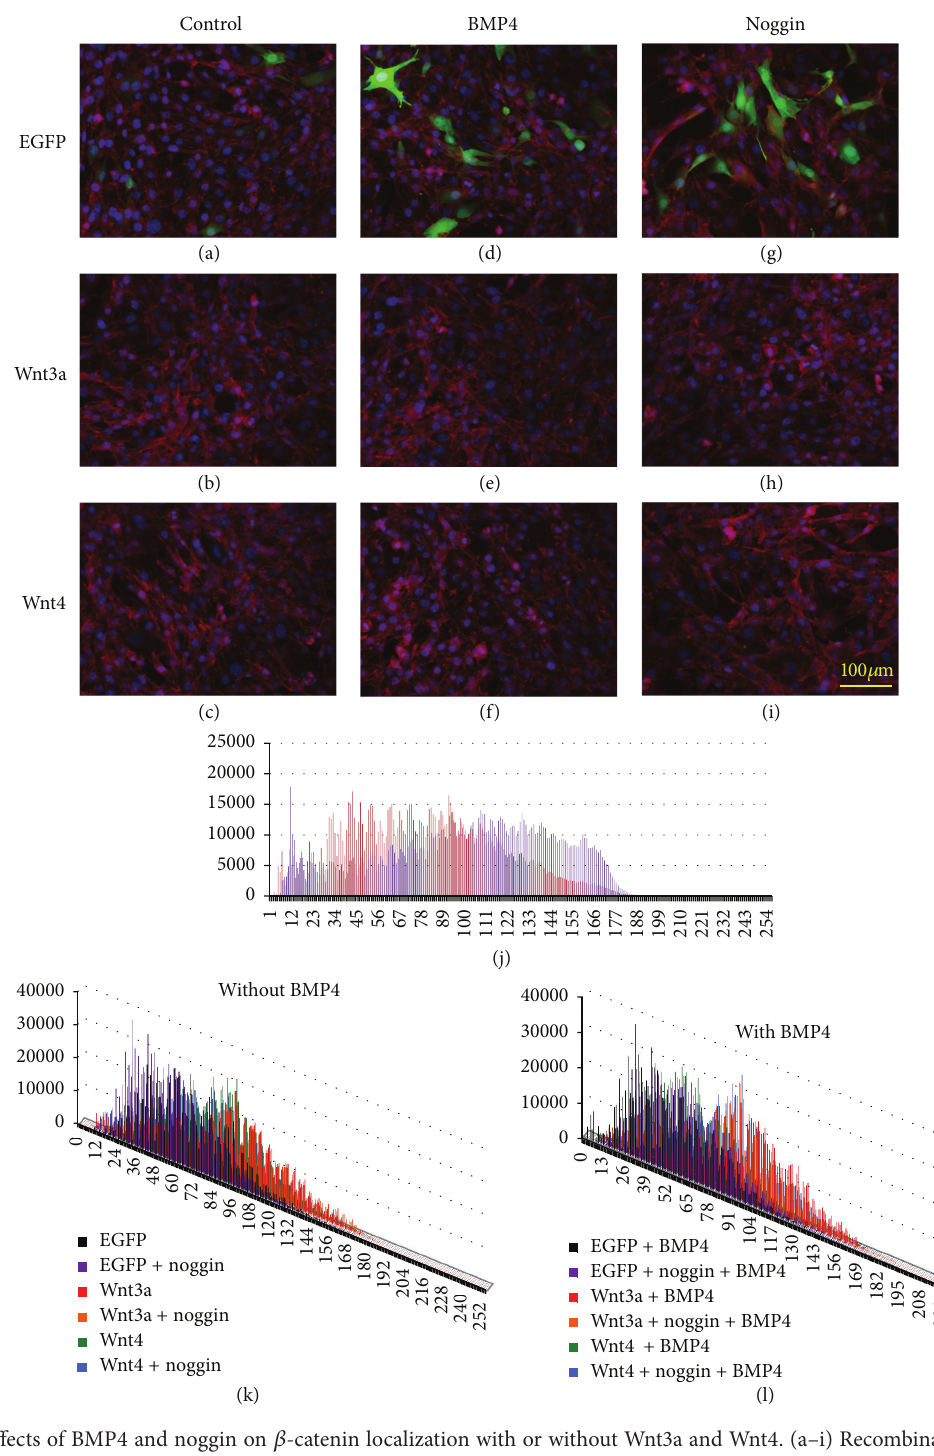
Figure 7: Effects of BMP4 and noggin on 𝛽 -catenin localization with or without Wnt3a and Wnt4. (a–i) Recombinant adenoviruses were used to express Wnt3a , Wnt4 , or eGFP (control) uniformly in C2C12 cells. Cells were infected 48 hours earlier with an MOI of 400, and the recombinant proteins were added as shown in Figure 3 with final concentrations of 5ng/mL BMP4 and/or 250 ng/mL noggin. Two hours after BMP4 addition, immunostaining for 𝛽 -catenin was carried out for counting. (j) Comparison of the 𝛽 -catenin signals after adenovirus- mediated expression of Wnt3a and eGFP , after pixel intensity analysis for immunohistochemical signals with BZ-II Analyzer, shown in abscissa for signal intensity and ordinate for frequency. Wnt3a intensified signals to a higher level. (k and l) Comparison of the 𝛽 -catenin signalsafteradenovirus-mediatedexpressionof Wnt3a , Wnt4, and eGFP ,inthepresenceorabsenceofBMP4and/ornoggin.Immunostaining for 𝛽 -catenin was analyzed by digitizing the signals with BZ-II Analyzer for comparison. Typical results are shown. (k) Without BMP4; (l) with